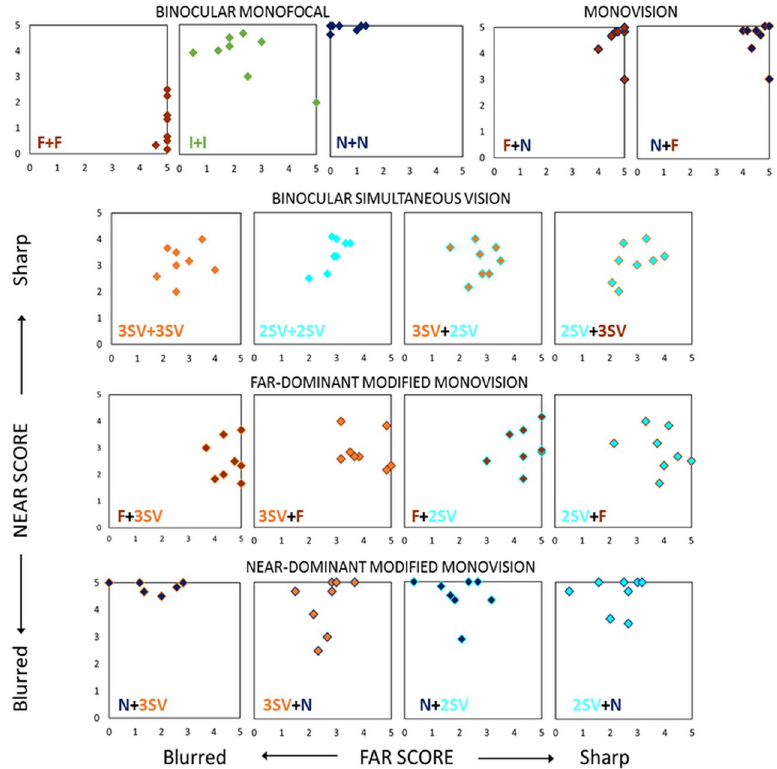
Fig 3. Binocular perceptual score for far (x-axis) vs near (y-axis) for each correction (each box) and each subject (each symbol).